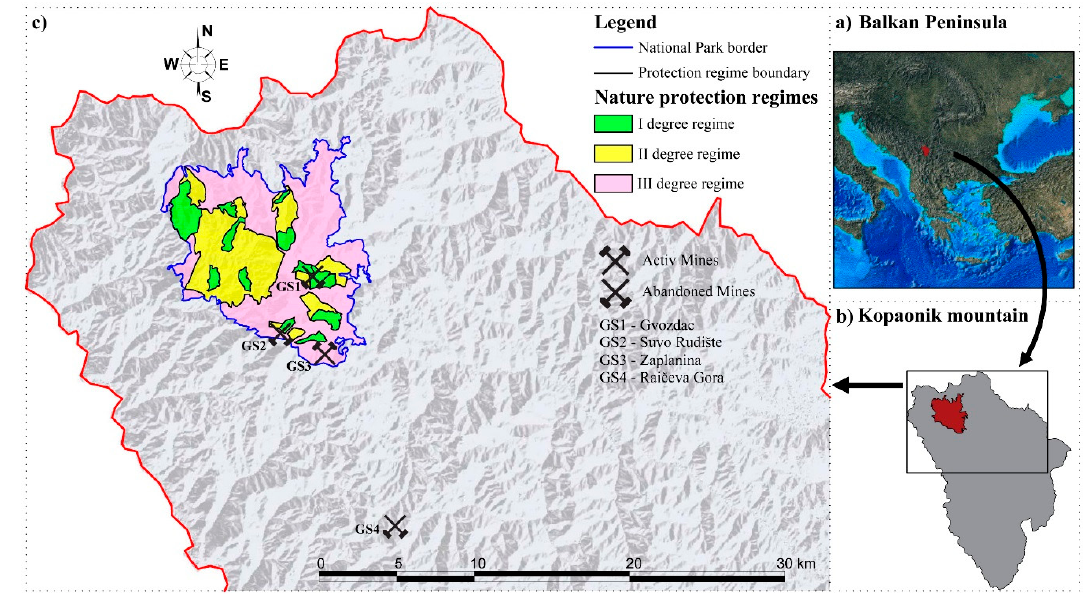
Figure 2. View of mines and protection zones in Kopaonik area.